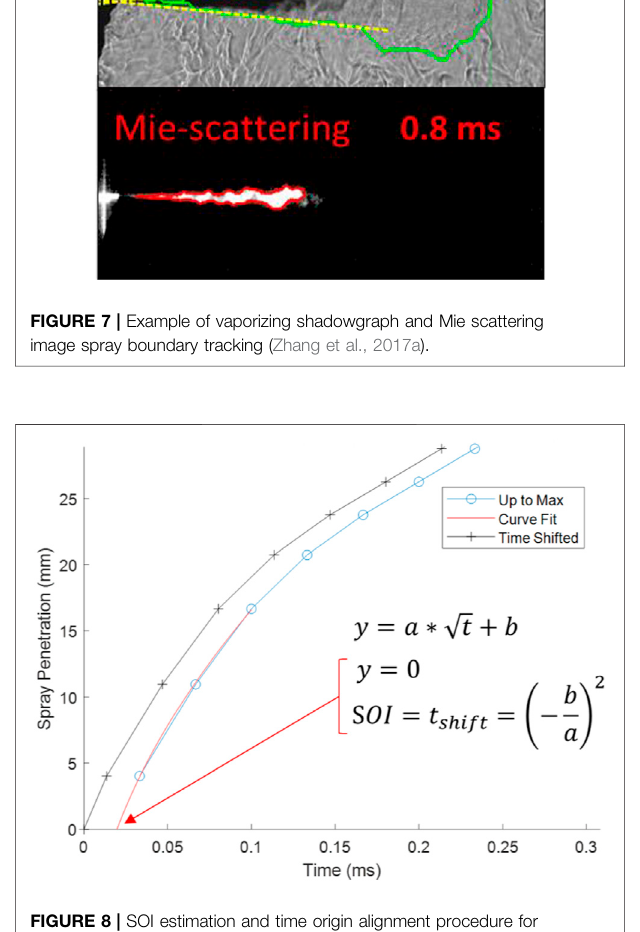
FIGURE 8 | SOI estimation and time origin alignment procedure for penetration curves.